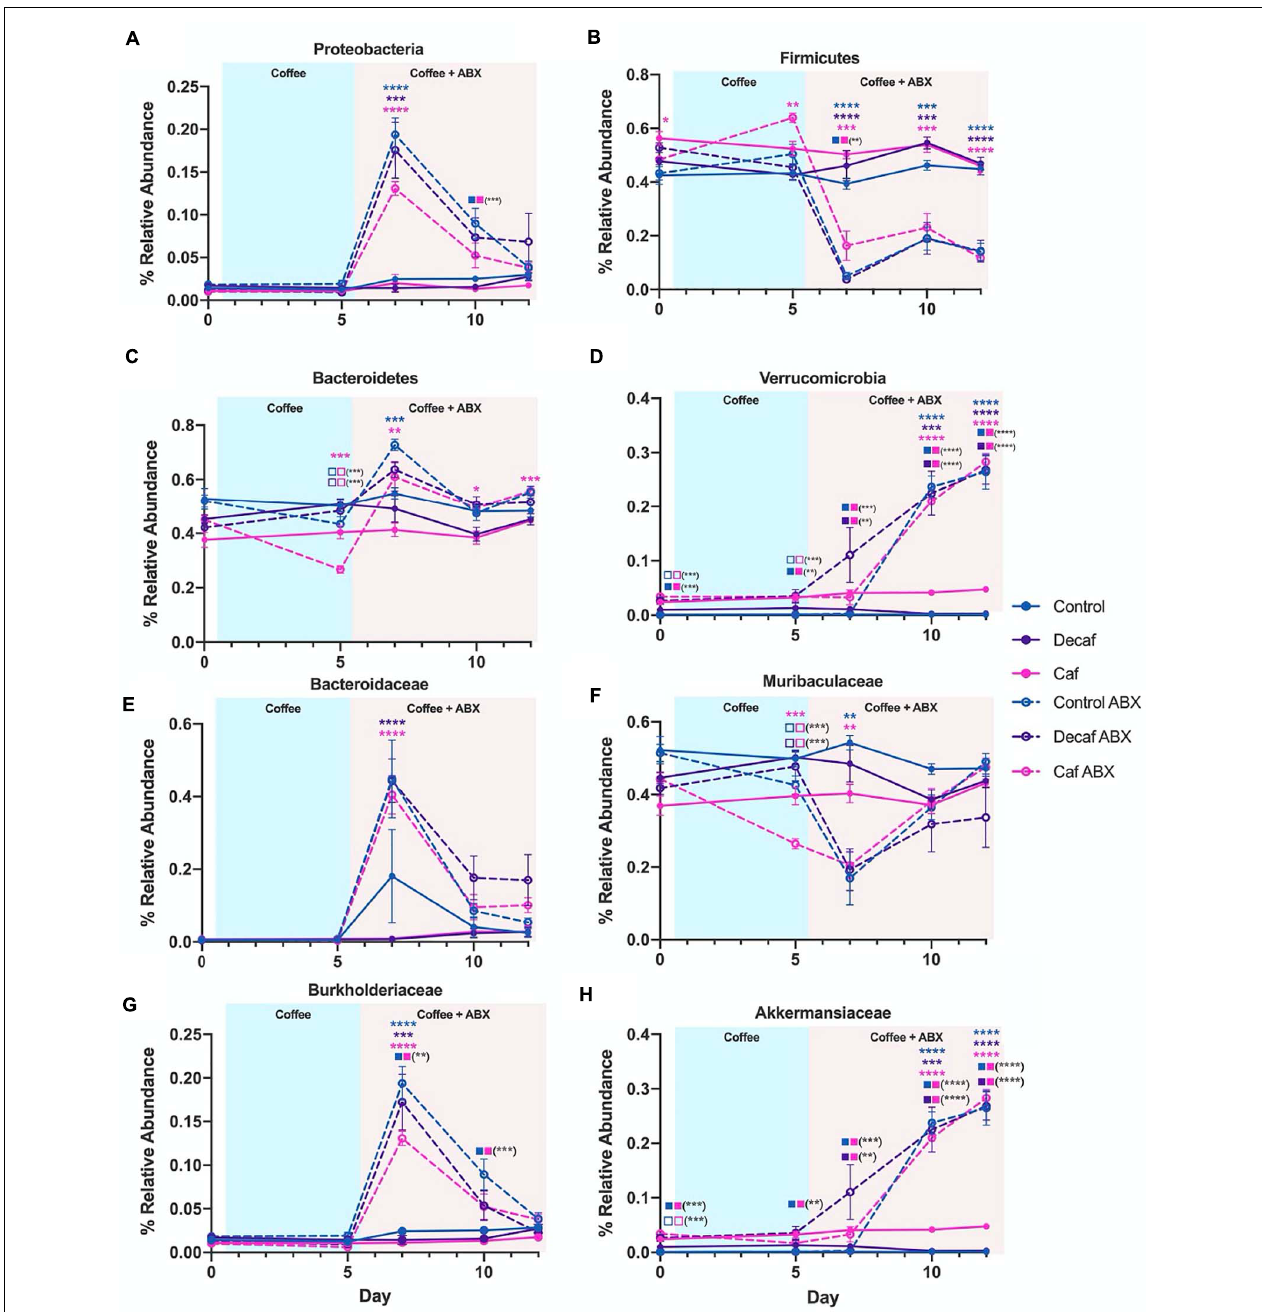
FIGURE 4 | (A–H) Relative abundance of notable phyla and families over the course of the experiment. Data are represented as mean ± SD. Significance was determined by the Benjamini, Krieger and Yekutieli test to correct for False discoveries with adjusted p -value < 0.05 (*, 0.01 < P < 0.05; **, 0.001 < P < 0.01; ***, 0.0001 < P < 0.001; ****, P < 0.0001). Significance between each experimental group and its antibiotic counterpart is denoted by stars (*) with the color coordinating to control (ctrl, blue), decaffeinated coffee (decaf, purple), or caffeinated coffee (caf, pink). Significance between different experimental groups is denoted by squares color-coded according to the experimental groups being compared. Solid squares represent groups without antibiotics, open squares represent groups given antibiotics. Each comparison of two experimental groups has its corresponding significance denoted in stars (*) next to it. For example, in the Bacteroidetes graph (C) on Day 5, the 3 pink stars represent a significant difference between the caf no-antibiotic group and the caf antibiotic group, at a significance level of 3 stars. Below that, the open blue square next to the open pink square represents a significant difference between the control antibiotic group and the caf antibiotic group, at a significance level of 3 stars (shown in parentheses). Below that, the open purple square next to the open pink square represents a significant difference between the decaf antibiotic group and the caf antibiotic group, at a significance level of 3 stars (shown in parentheses).